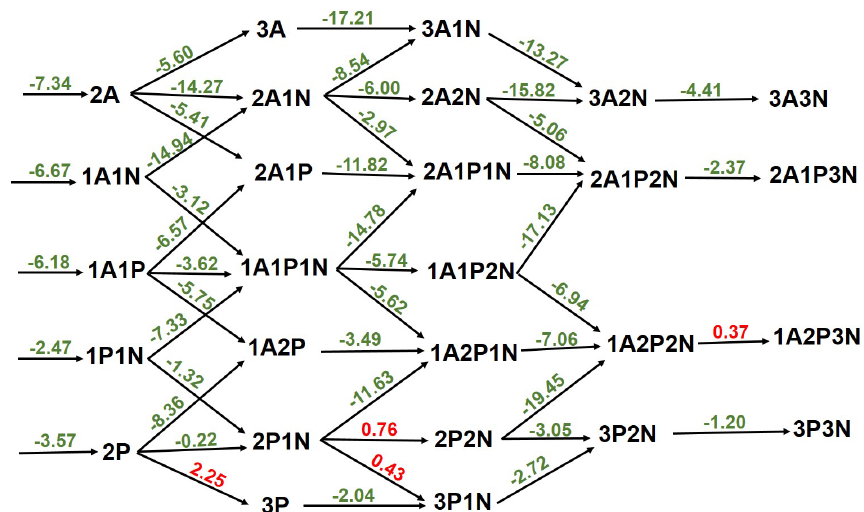
Figure 3. Gibbs free-energy (in kcalmol − 1 ) diagram of sulfuric-acid–pyruvic-acid–ammonia clusters at 298K and 1atm. “A” refers to sulfuric acid, “P” refers to pyruvic acid and “N” refers to ammonia. Green color indicates exergonic processes and red color indicates endergonic